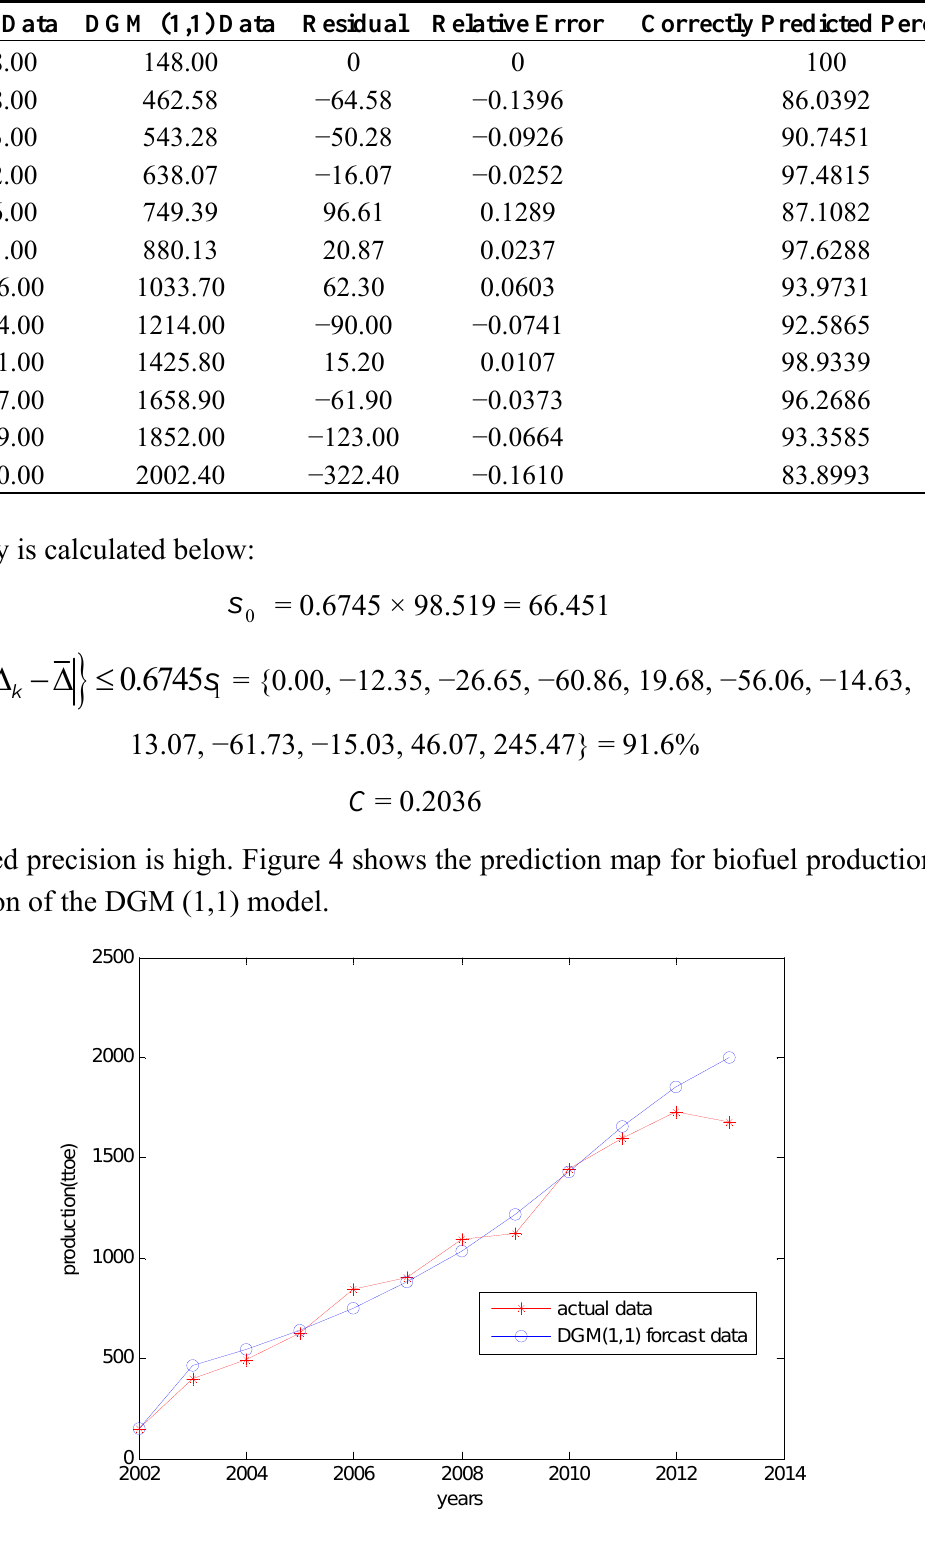
Figure 4. Prediction map for biofuel production using the eighth dimension of the discrete grey forecasting model DGM